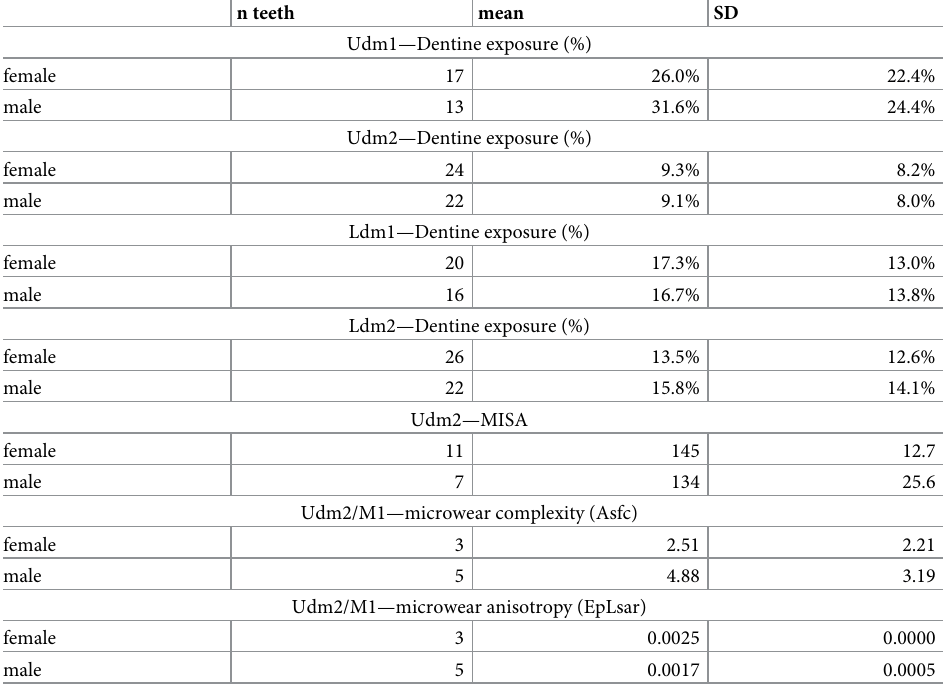
Table 6. Comparison of dentine exposure (area of exposed dentine in % of the occlusal surface), occlusal topogra- phy (MISA, mesial interior slope angle), and dental microwear texture (Asfc and epLsar) between male and female